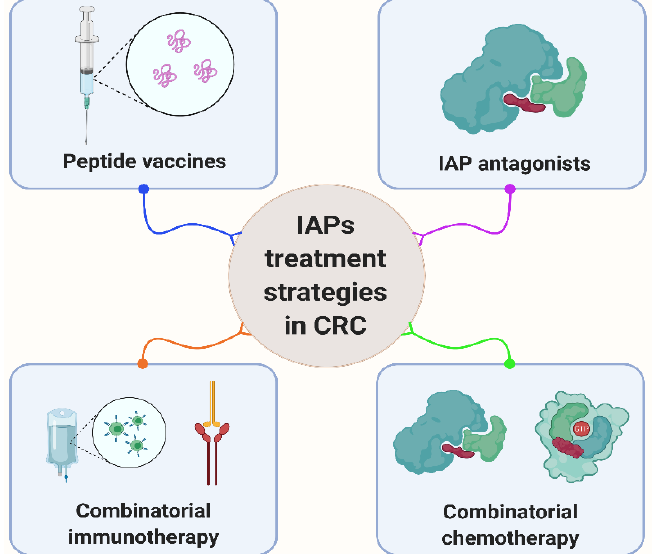
Figure 3. Therapeutic strategies that target IAPs in CRC. Current approaches include peptide vac- cines, IAP antagonists and combinatorial treatment strategies further empowering with immuno-/chemotherapeutics such as anti-PD1 antibodies. Further details are given in the text and in Table 2.